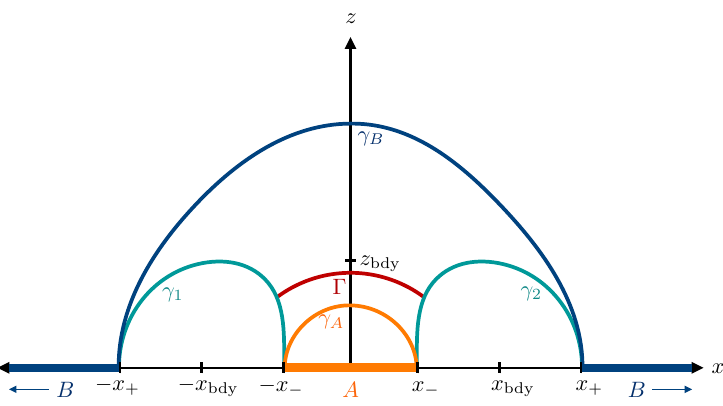
(cid:13) 1 + (cid:13) 2 < (cid:13) A + (cid:13) B , the j j j j j j j j